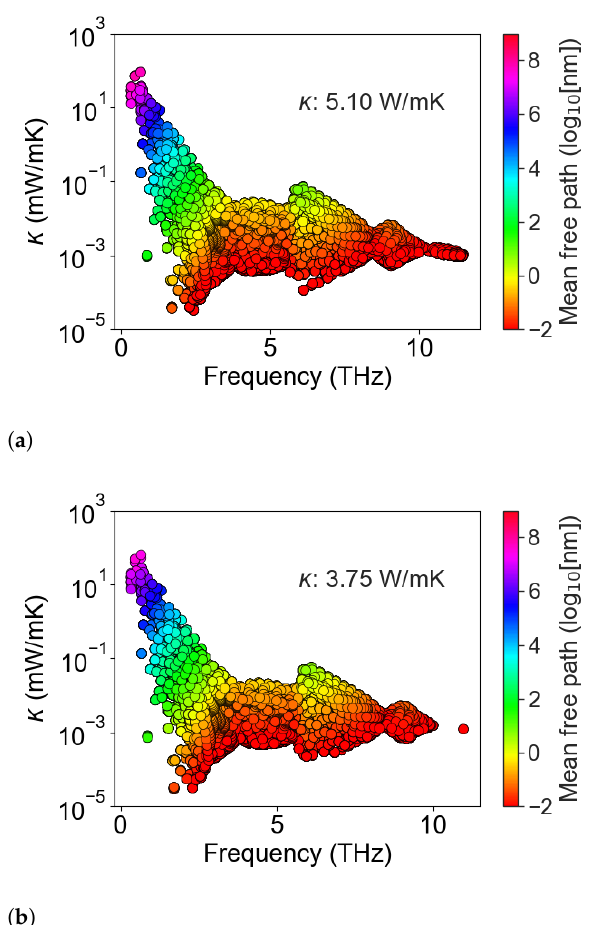
Figure A2. Mode-resolved thermal conductivity across the frequency spectrum in porous Si 0.8 Ge 0.2 with 5 µ m pore–pore spacing with ( a ) cylindrical pore and ( b ) triangular prism